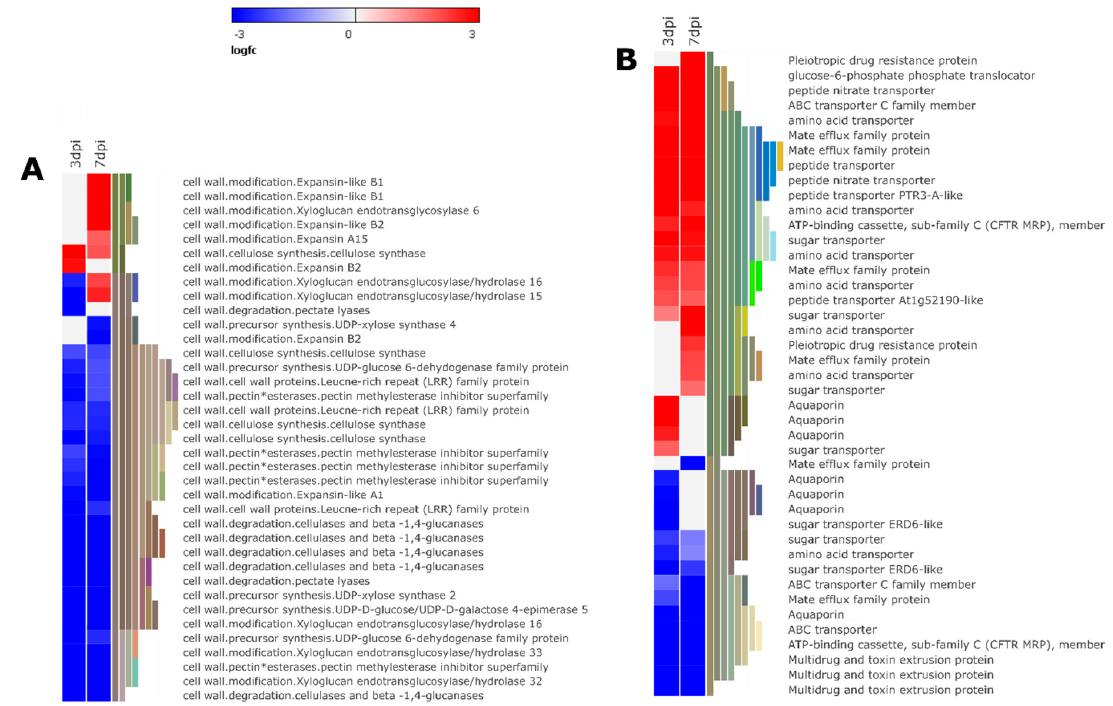
Figure 8. Heat map representation of gene expression patterns of genes associated with cell wall architecture ( A ) and transport activity ( B ). (The heat map illustrates a subset of genes from each group. Refer to supporting information for all differentially expressed genes in each group ).